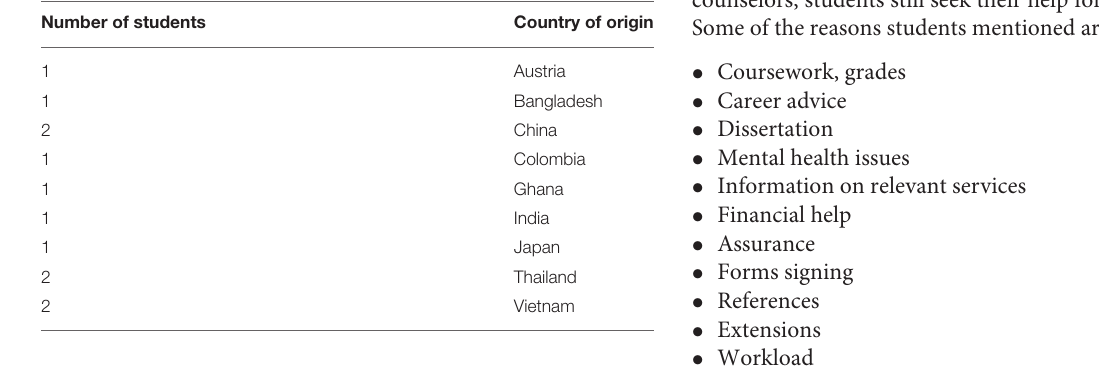
TABLE 3 | Number of students by country of